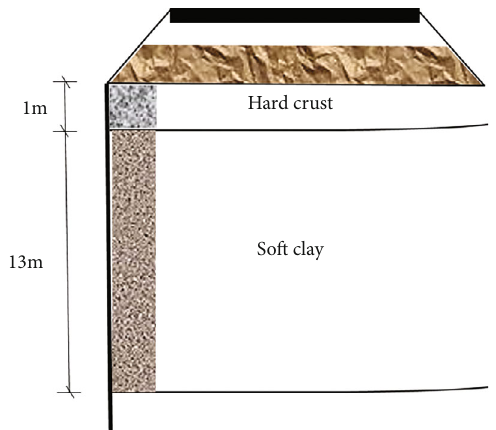
Figure 10: Calculation diagram of soil